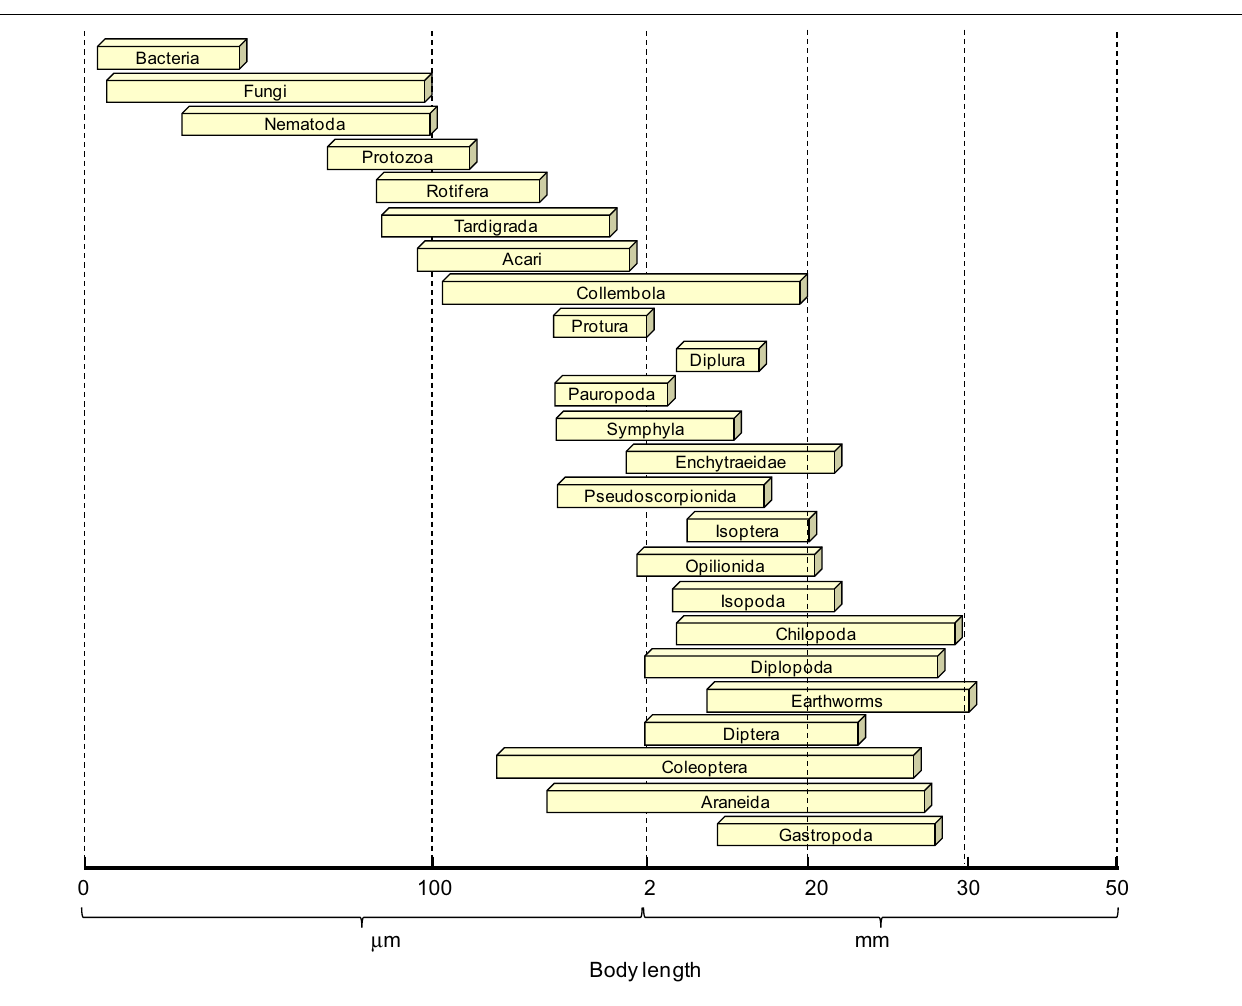
FIGURE 1 | Soil fauna size distribution using body length as a classifying